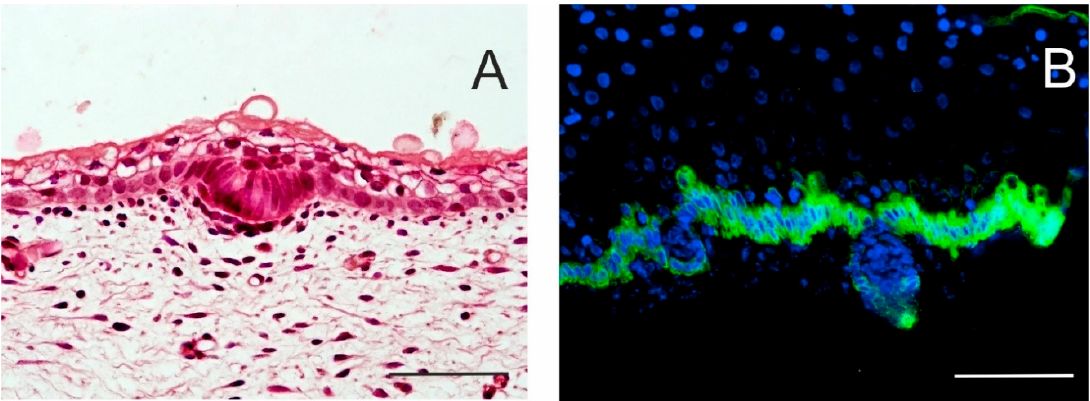
Figure 2. Initial stages of hair follicle (HF) formation. Local proliferation of epidermal stem cells results in epidermal thickening, characterizing an epidermal placode. Basal columnar cells communicate actively with mesenchymal cells that cluster under the basement membrane. Skin of a 14-week human embryo, haematoxylin–eosin staining ( A ). In a 17-week human embryo,